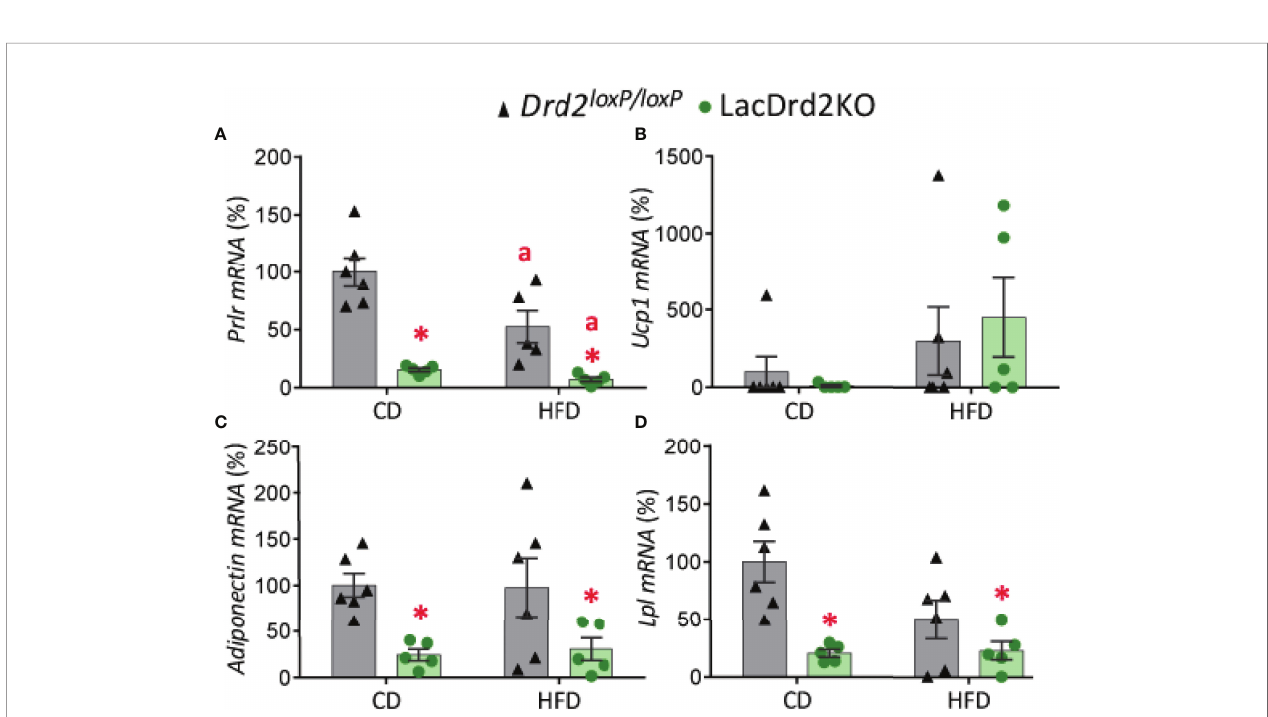
FIGURE 5 | Impact of hyperprolactinemia and high-fat diet on gene expression pro fi le of subcutaneous white adipose tissue. mRNA levels of (A) Prlr , (B) Ucp1 , (C) adiponectin and (D) Lpl , in 5- month-old Drd2 loxP/loxP and lacDrd2KO female mice with free access to a control diet (CD) or a HFD. Drd2 loxP/loxP mice (CD, n = 5; HFD, n = 6), lacDrd2KO mice (CD, n = 5; HFD n = 5). Two-way ANOVA; “ a ” = P ≤ 0. 05 vs. genotype-matched mice fed with control diet, * P ≤ 0.05 vs. diet-matched Drd2 loxP/loxP